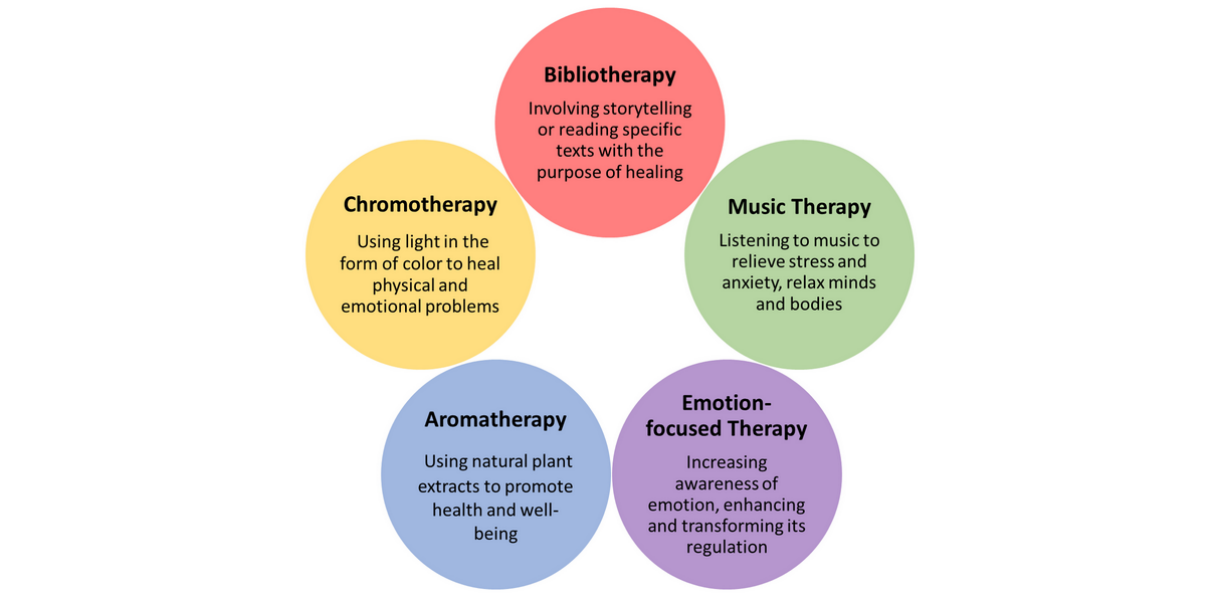
Figure 1. Psychological therapeutic interventions and